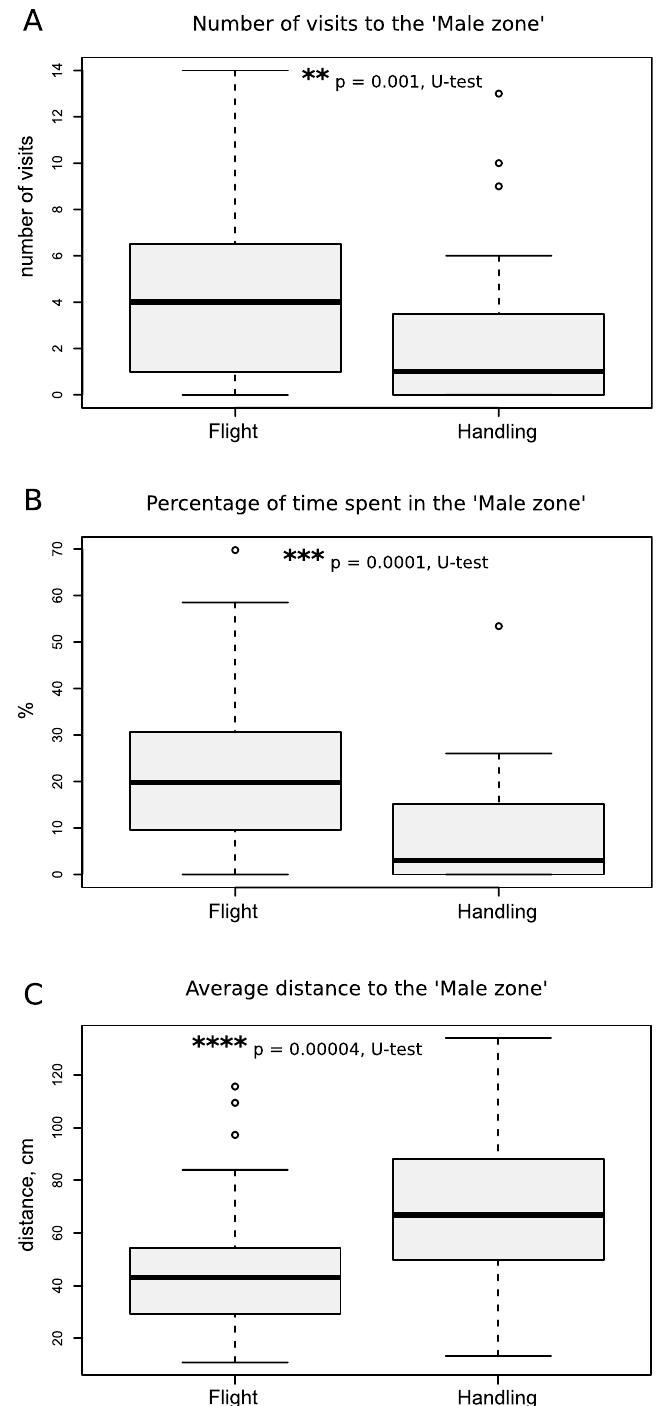
Figure 2. Quantitative parameters of sexual searching behavior in the ’flight’ and ’handled’ groups of female crickets. ’Flight’ crickets visited the ’Male zone’ more often (A) , spent relatively more time there (B) and had lower average distance, i.e. higher affinity, to the ’Male zone’ (C) . The bold center time gives the median, boxes the interquartile range and whiskers 1.5 times the interquartile range. Data beyond this range (’outliers’) are shown individually as points. Asterisks indicate the statistically significant differences according to the Mann– Whitney U test. Basic statistical analyses and drawings were conducted using the R 34